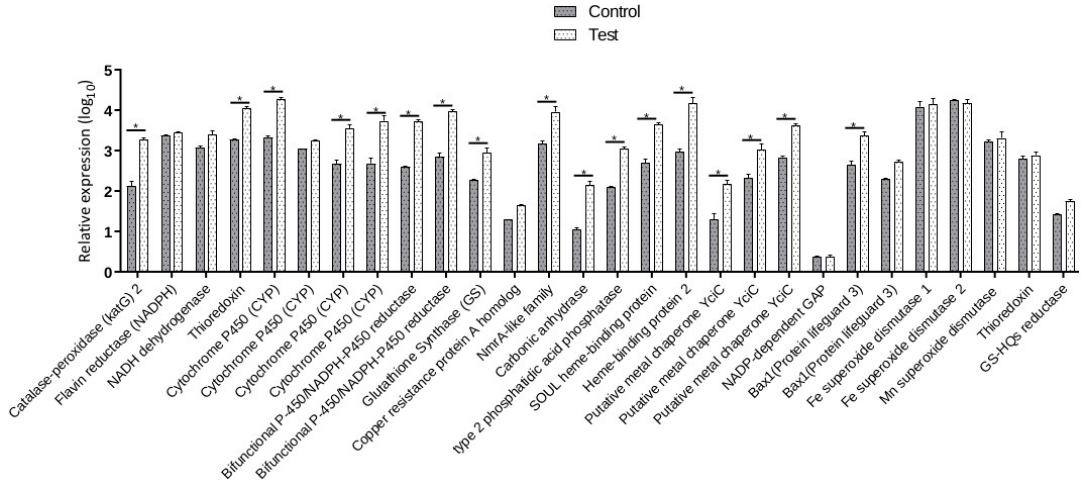
Figure 5. RT-qPCR analyses of 28 heavy metal stress-related genes under the control and Hg treatment in C. velia cultures. Each bar represents the mean ± SD of triplicate assays. Values with different letters indicate significant differences at p < 0.05, according to Duncan’s multiple range tests.